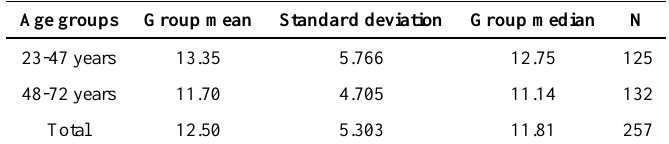
Table 4. Scores for the behavioural component of the attitudes towards inclusive education – age